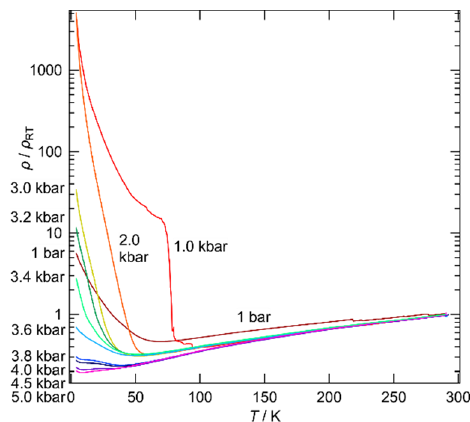
Figure 9. Electrical resistivity under pressure of 1